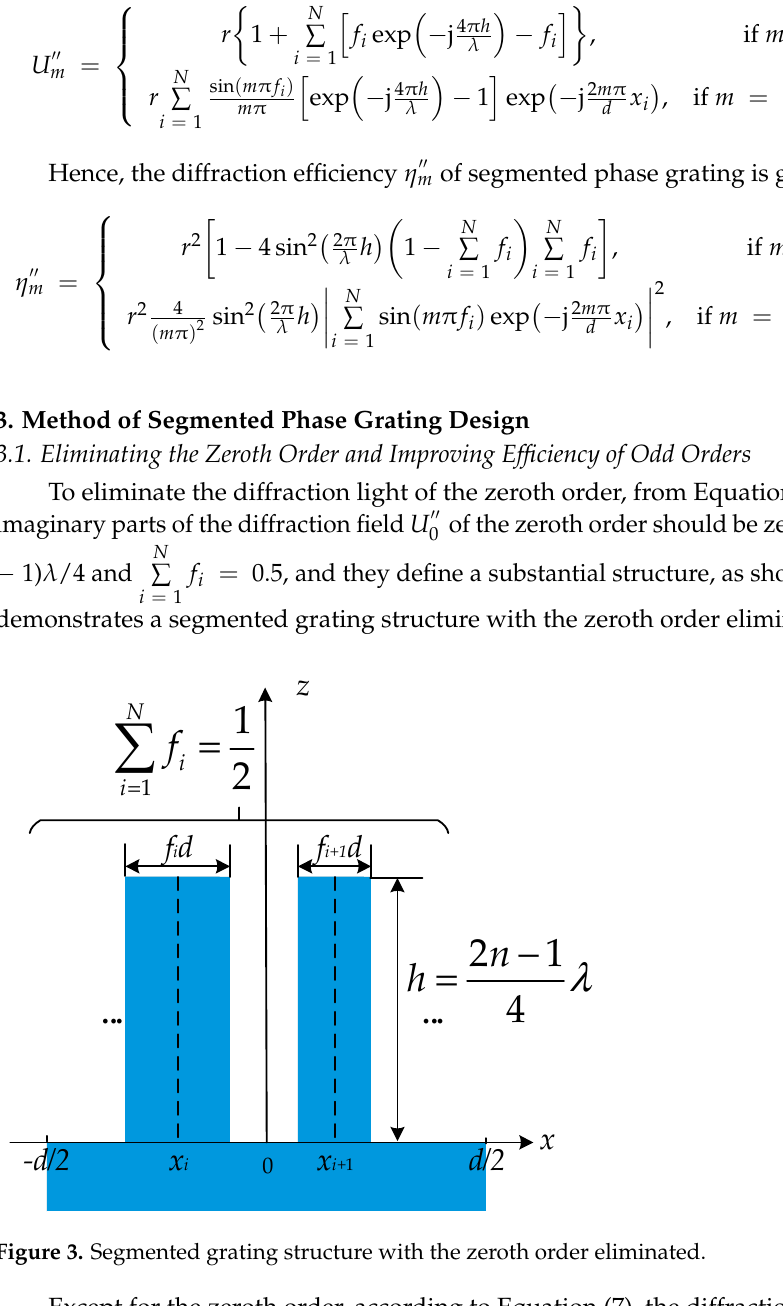
Hence, to improve the diffraction efficiency η (cid:48)(cid:48) m , U m needs to have the maximum amplitude and all U ( m , i ) have the same